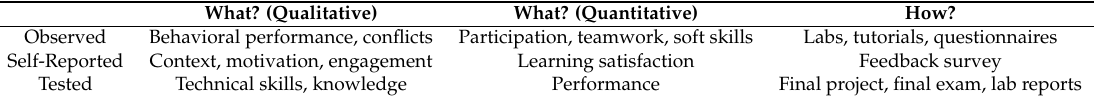
Table 1. Main characteristics of the outcome measurement